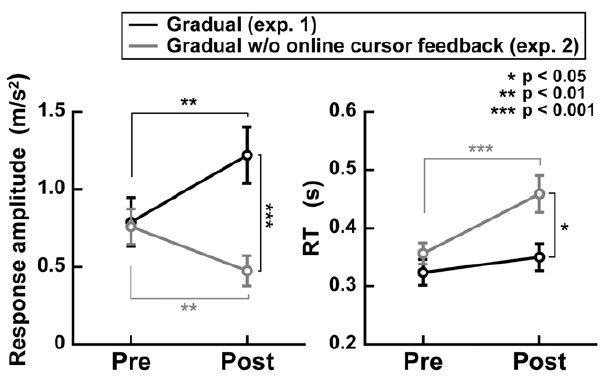
Figure 5. Response amplitudes to cursor perturbation and RTs after learning with and without online cursor feedback. Left and right panels show the mean amplitudes of acceleration responses to the cursor perturbation and the mean RTs for the reaching initiation across subjects, respectively. Black lines indicate the gradual condition with online cursor feedback (exp. 1) and gray lines indicate the gradual condition without online cursor feedback (exp. 2). Note that the data indicated by the black lines are the same as those represented by the gray line in Fig. 4C (response amplitude) and the green line in top-right panel of Fig. 2B (RT). The asterisks (*, **, and ***) denote the significance of differences: p , 0.05, p , 0.01, and p , 0.001, respectively.